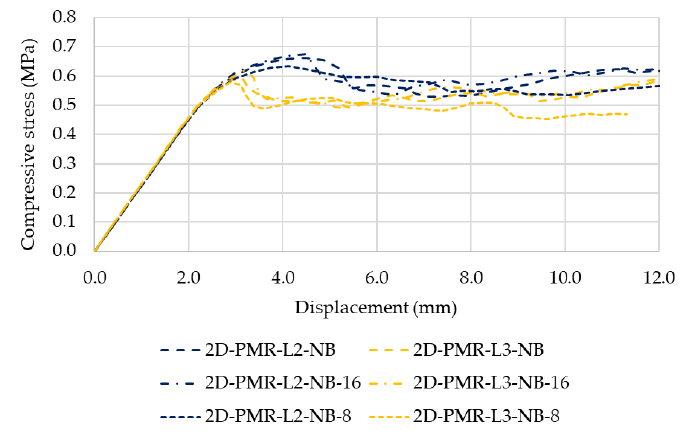
Figure 21. Stress–displacement diagrams for 2D-PMR models with a three-level reinforcement solution and a no-bond assumption: connector diameter assessment.